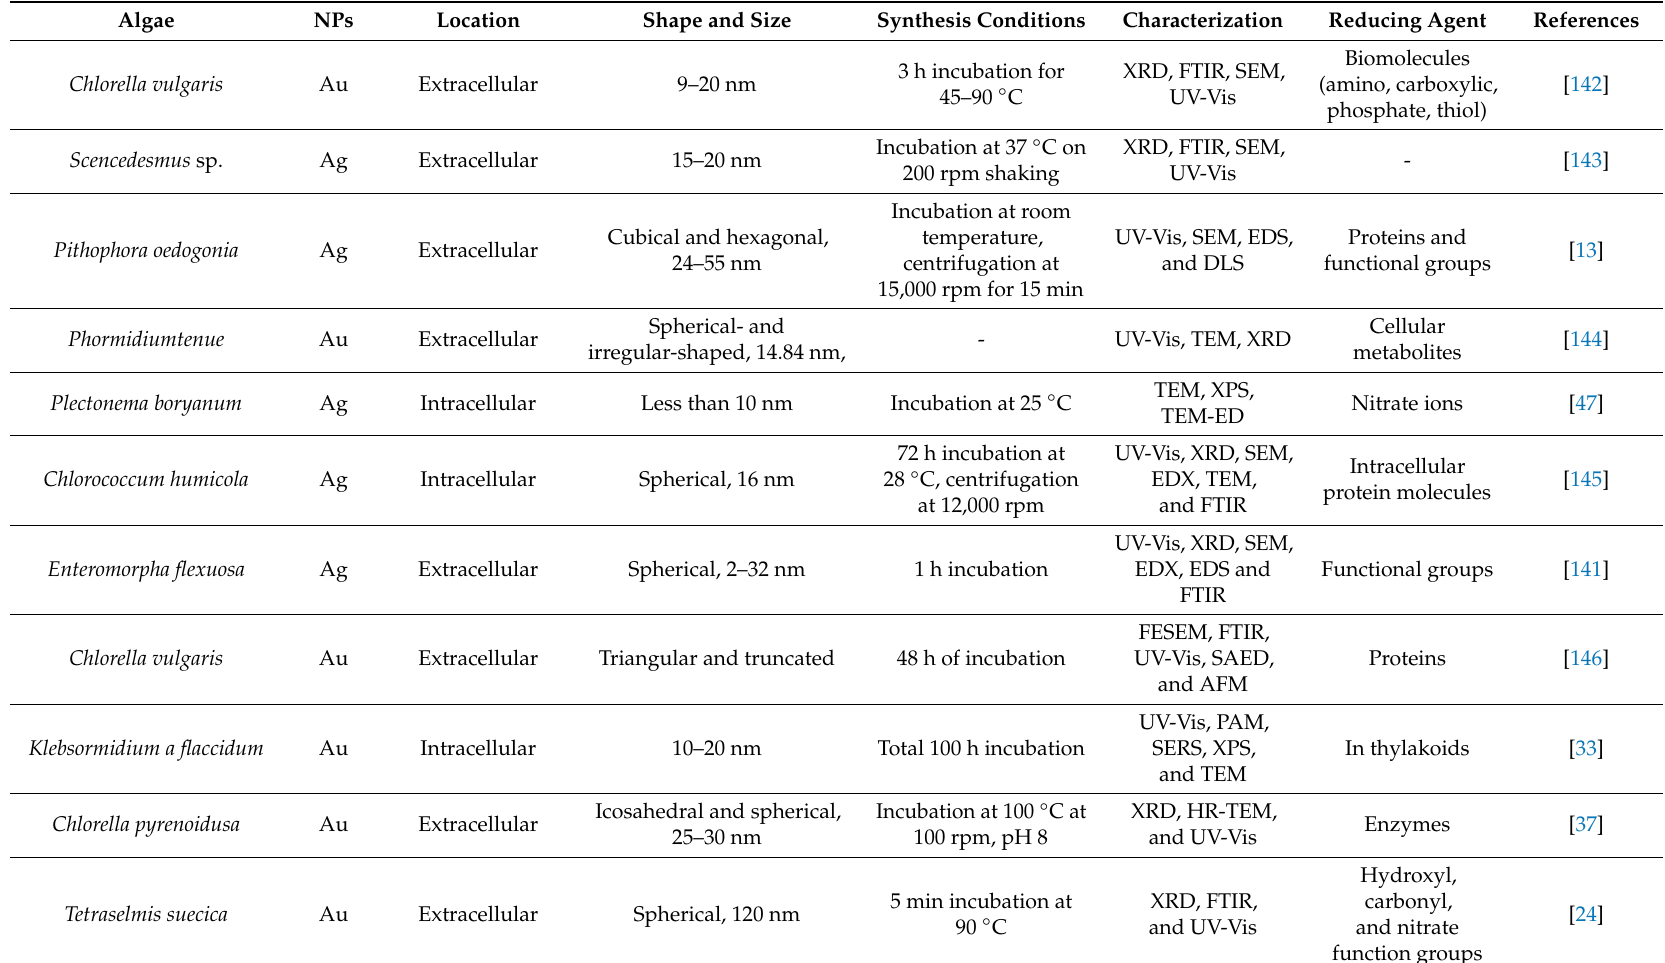
Table 4. Micro green algae-mediated biosynthesis of Metallic